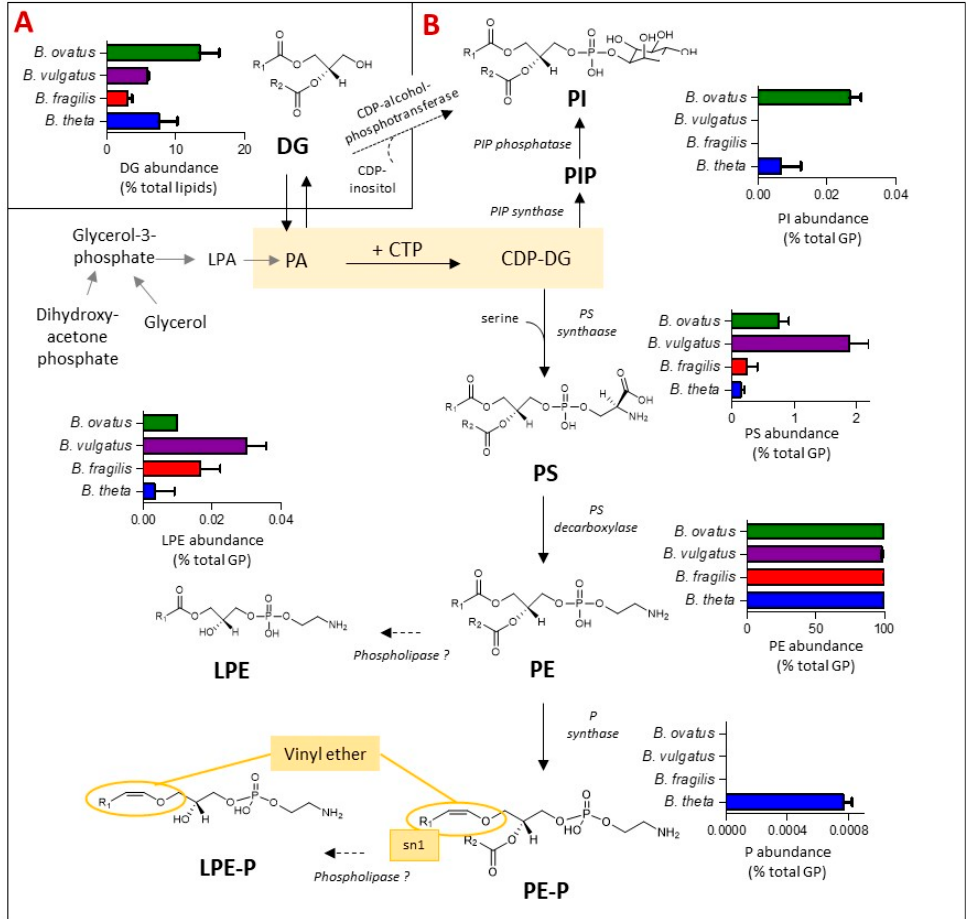
Figure 4. The presence of plasmalogens and phosphoinositol (PI) lipids is dependent on the Bac- teroides species . The schematic indicates the relative representation of each lipid species and the proposed genetic and biochemical pathways contributing towards their production. ( A ) Relative abundance (expressed as % total lipid) of diacylglycerols (DG) for the four Bacteroides tested. DG act as metabolic intermediates in the biosynthesis of Bacteroides glycerophospholipids (GP). ( B ) Relative abundance (expressed as % total GP) of glycerophosphoinositol (PI), glycerophosphoserine (PS), glyc- erophosphoethanolamines (PE), mono-acylated or lyso PE (LPE) and the vinyl-ether containing plas- malogens (P), glycerophosphoethanolamines plasmalogen (PE-P) and lysophosphatidylethanolamine plasmalogen (LPE-P). Other abbreviations are: cytidine diphosphate-DG (CDP-DG); PI phosphate (PIP); glycerophosphoethanolamines plasmalogen (PE-P); PA: lycerophosphatic acid; lyso PA